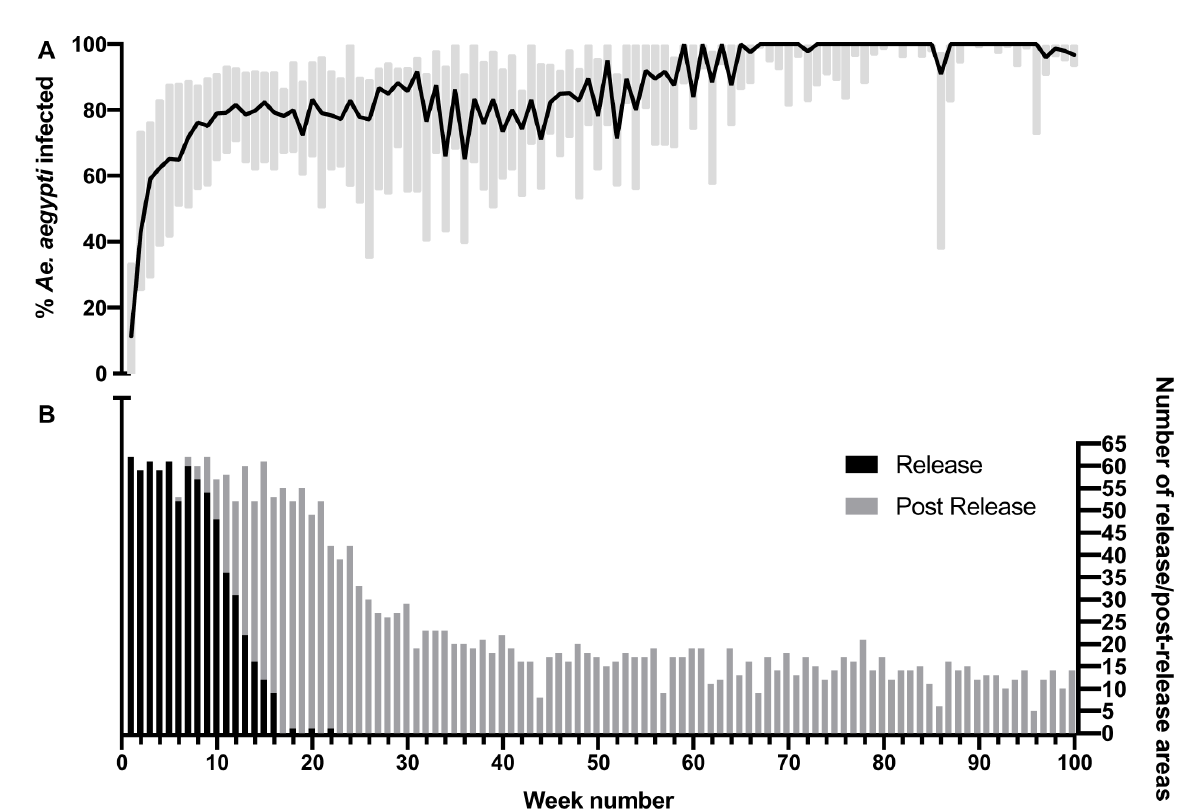
Figure 5. Wolbachia infection rates in Aedes aegypti mosquitoes collected from individual release areas during release and post- release monitoring periods. Line represents median percentage infection rate across 62 individual release areas, box represents interquartile range, Week number 1 corresponds to commencement of Wolbachia mosquito releases in each area. ( A ), Number of release and post- release areas monitored each week ( B